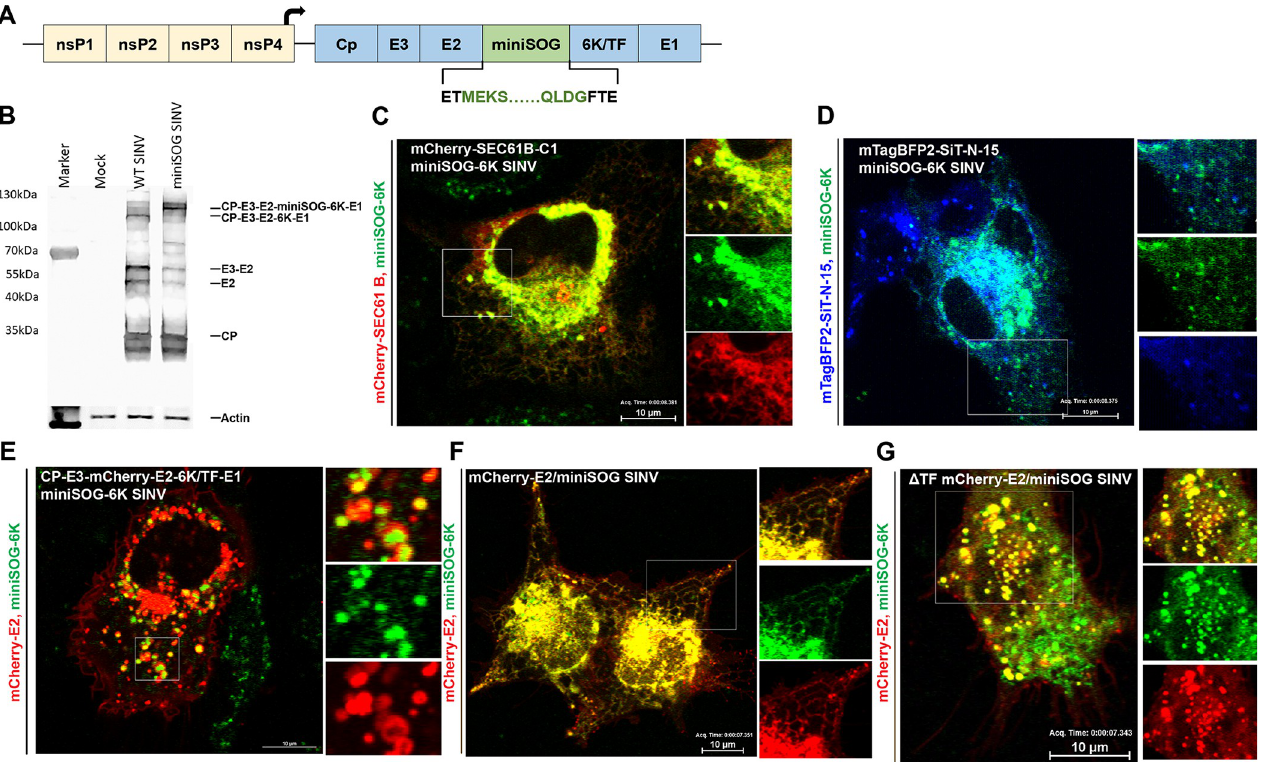
Fig 4. Subcellular localization of 6K in infected cells. (A) Schematic of the miniSOG-6K SINV construct. The sequence encoding the fluorescent protein miniSOG was cloned into WT toto64 after Thr 2 of 6K as an N-terminal fusion. (B) Western blot analysis of the cell lysates from BHK-15 cells infected with WT SINV or miniSOG-6K SINV. The blot was probed with an anti-E2 primary antibody to detect the structural polyprotein processing intermediates. (C-E) Representative images of BHK-15 cells transfected with mCherry-SEC61B-C1 (red) (C), mTagBFP2-SiT-N-15 (blue) (D), or CP-E3-mCherry-E2-6K/TF-E1 (red) (E), and infected with miniSOG-6K SINV (green). Imaging was performed at 12 hpi. Regions of interest are marked and enlarged to the right as separate channels. Images correspond to videos (S3–S5 Videos) (F-G) Representative images of BHK-15 cells electroporated with RNA corresponding to the dual- labeled mCherry-E2/miniSOG SINV (mCherry-E2 is red and miniSOG-6K is green) (F) or Δ TF mCherry-E2/miniSOG SINV (mCherry-E2 is red and miniSOG-6K is green) (G) and imaged at 12 hpi Images correspond to videos (S6 and S7